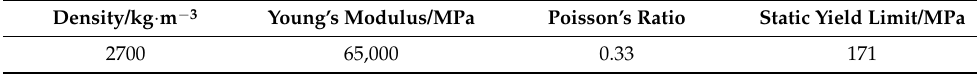
Table 1. Material parameters of Al 5005 for the FML